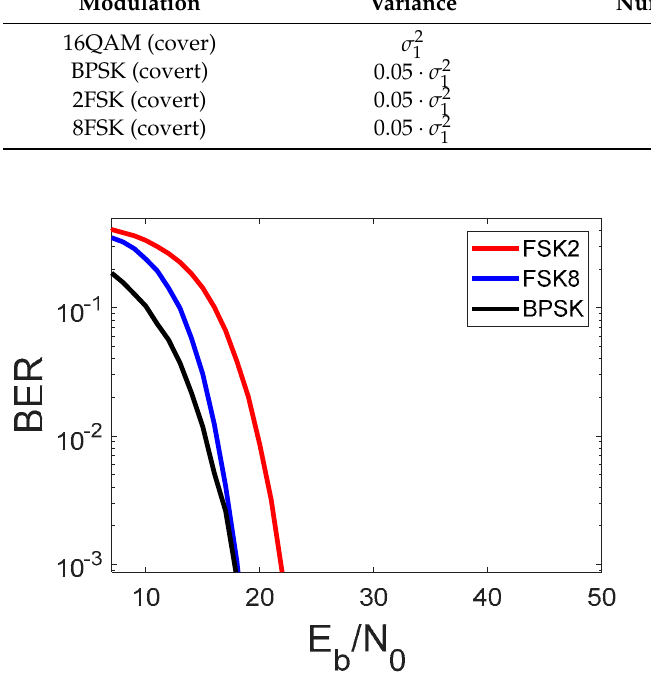
Figure 4. The comparative simulation of the covert data transmission in AWGN channel.